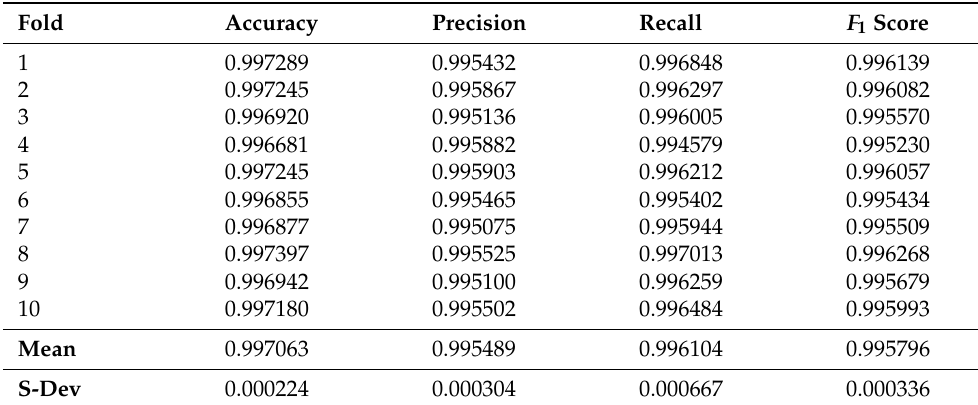
Figure 3. Confusion Matrix Plot of DT Classifier with 6 Features. Table 3. Results of 10-fold Cross-Validation Using DT